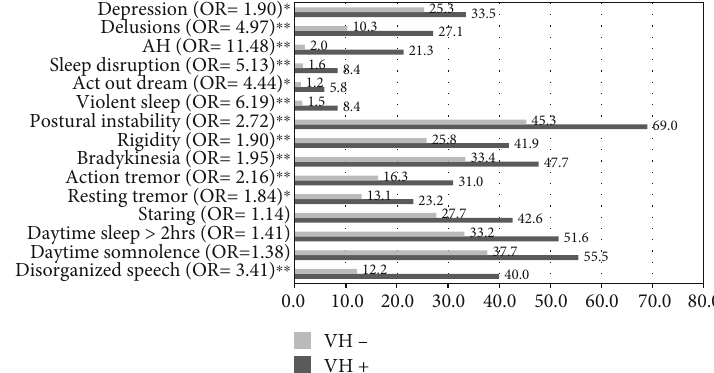
Figure 1: Percentage frequency of clinical feature characteristic of Lewy body dementia of VH+ compared to VH − . AH: auditory hallucination; ORs of variables were adjusted for age and disease severity as per the Clinical Dementia Rating scale. ∗ p < 0 : 01 ; ∗∗ p < 0 : 001